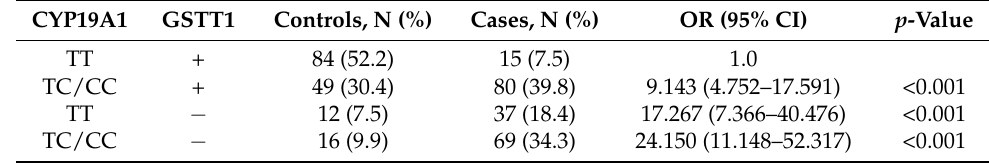
Table 10. Association between CYP19A1 and GSTT1 genotype combinations and female infertility.